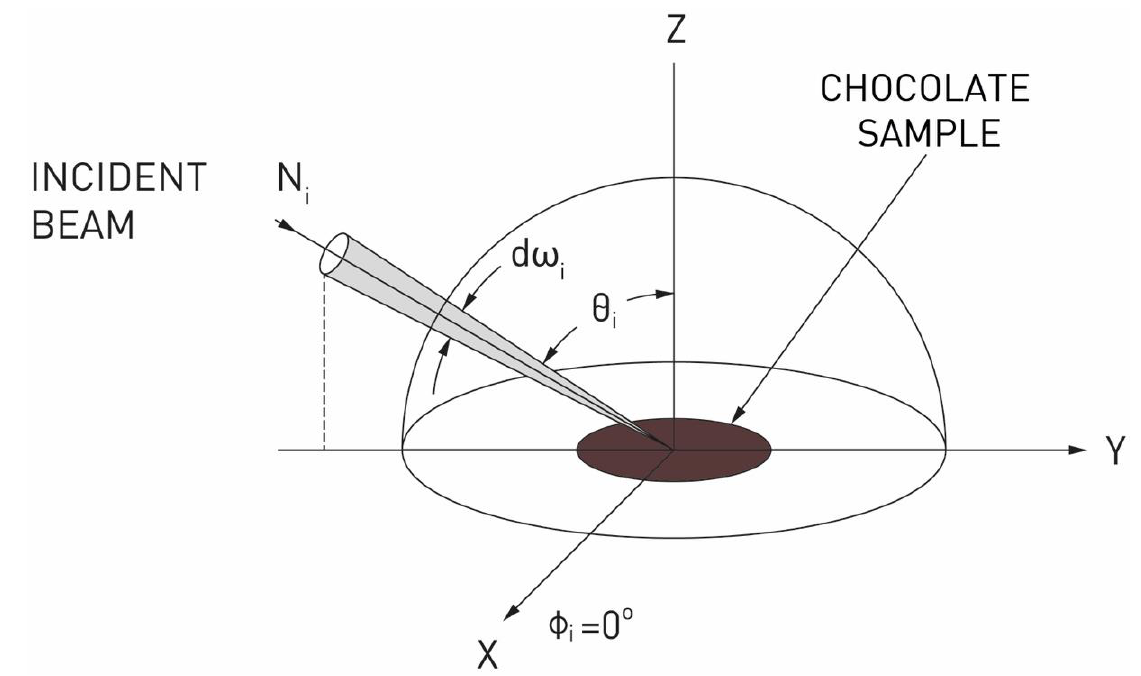
Figure 1. Diagram illustrating the concept of directional reflectance measurements of chocolate.